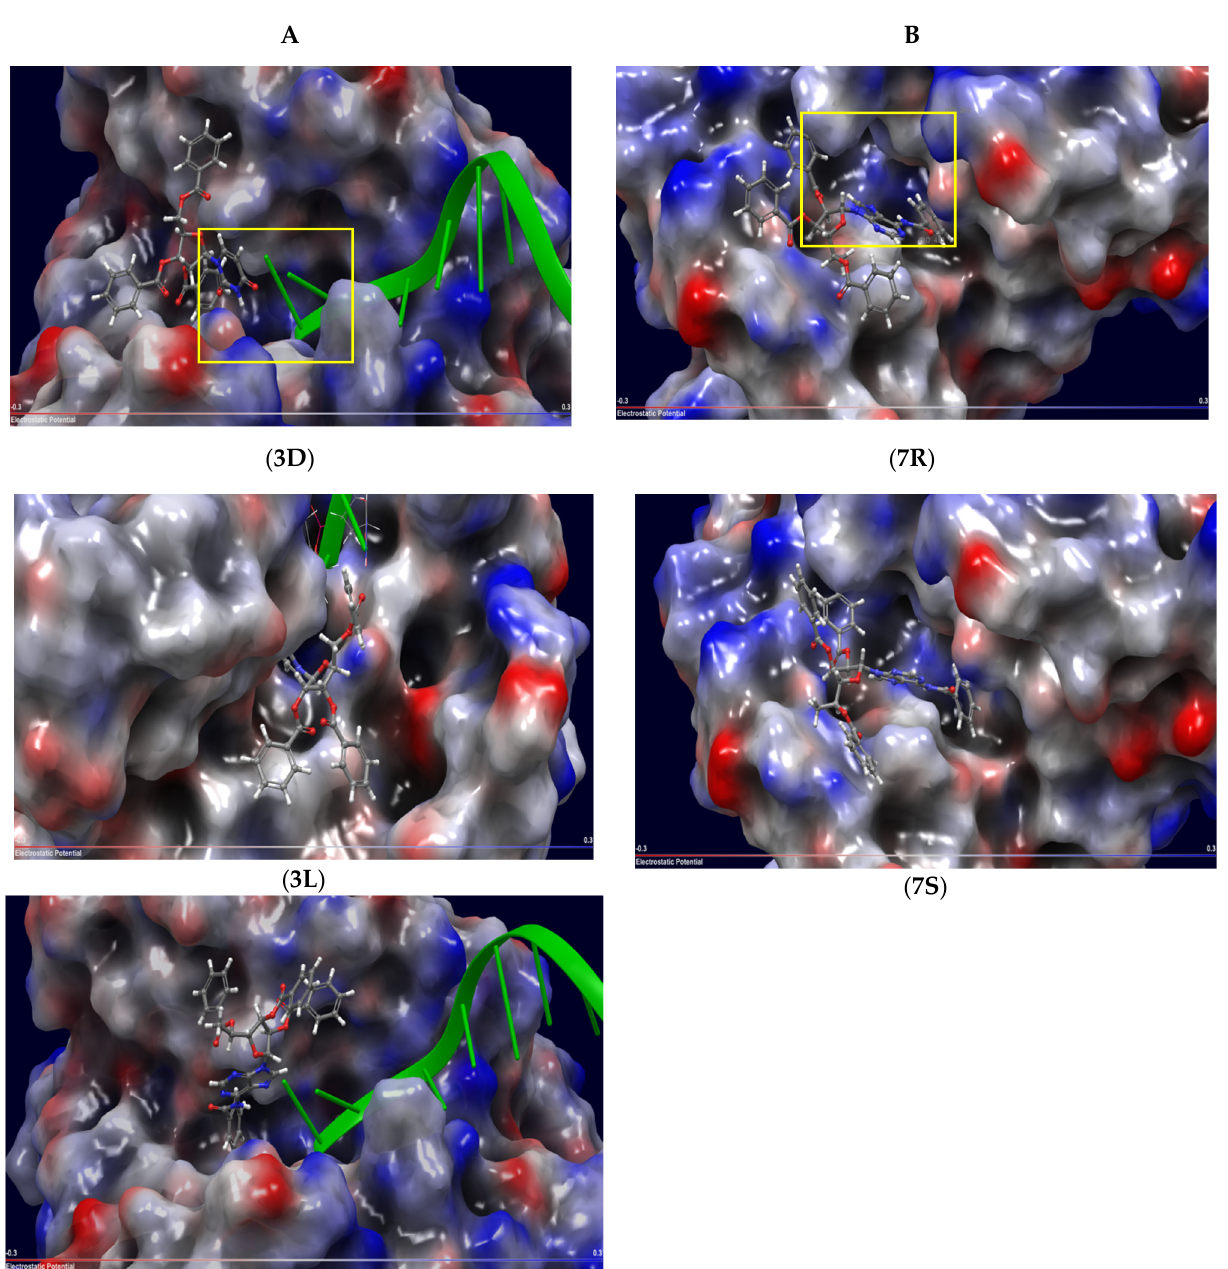
Figure 1. Molecular models of Tdp1 interactions with various types of inhibitors. ( A ) enzyme − substrate complex (Tdp1-DNA); ( B ) apo-form. Negatively charged regions are marked in red, positively charged regions are marked in blue, a DNA fragment is marked in green, and the enzymatic reaction center is marked by a yellow frame.